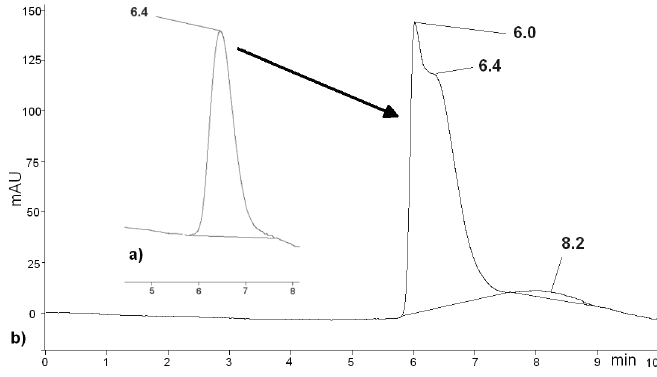
Figure 7: HPLC chromatograms of the methylolurea products a) before dilution; b) after 1:1 dilution with water.